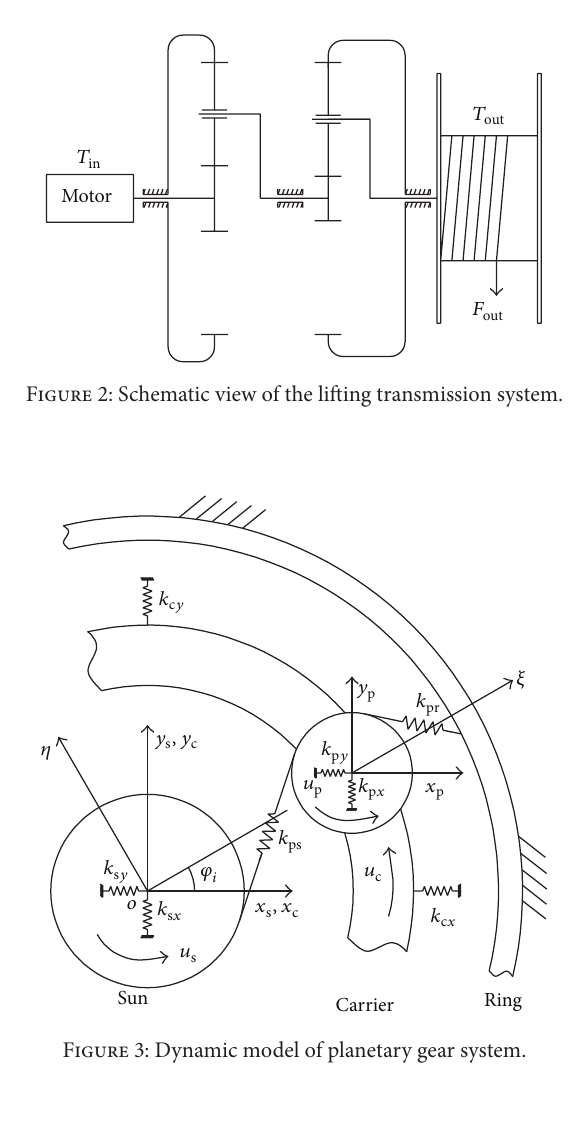
rotation coupling dynamic model of transmission system